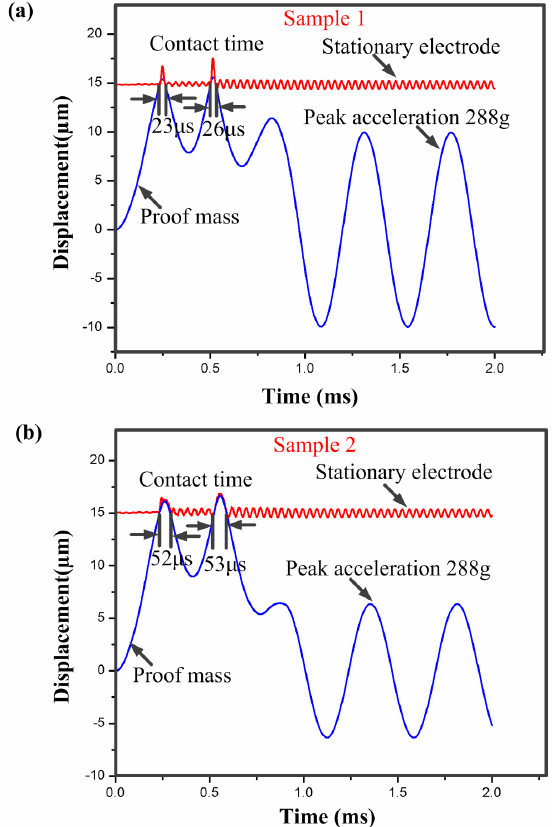
Figure 5. Dynamic response curves of the inertial micro-switch under the applied acceleration amplitude of 288 g. ( a ) Sample 1; and ( b ) Sample 2.